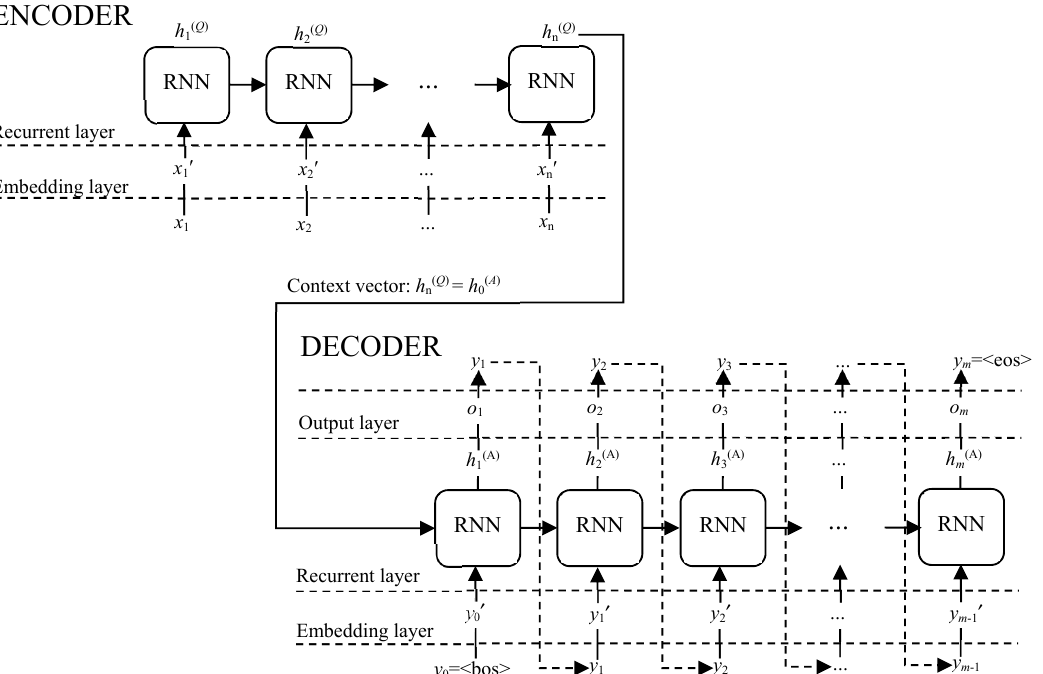
Figure 1. The basic recurrent-based encoder–decoder architecture.